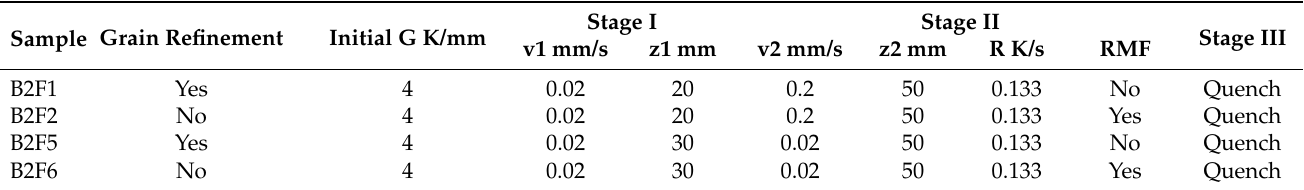
Table 1. Control parameters for the four samples solidified under microgravity; vn is the furnace pulling velocity, and zn is the furnace movement with vn in stage